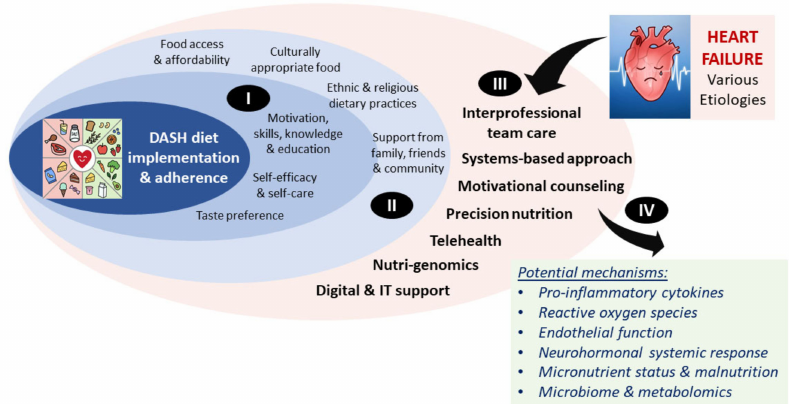
Figure 2. Potential predictors of DASH diet success and mechanisms underlying its positive effects in heart failure. The DASH diet effectiveness in HF risk reduction and management can be influenced by many different factors. Examples of individual patient-level factors (I) and factors associated with the environment, society, and culture (II), which are also intertwined with the individual patient-level factors, are shown. In addition, there are factors specifically associated with the clinical management of heart failure that may influence DASH diet success (III) Once successfully implemented and adhered to, the DASH diet may reduce HF risk through several different mechanisms associated with improved systemic and local responses